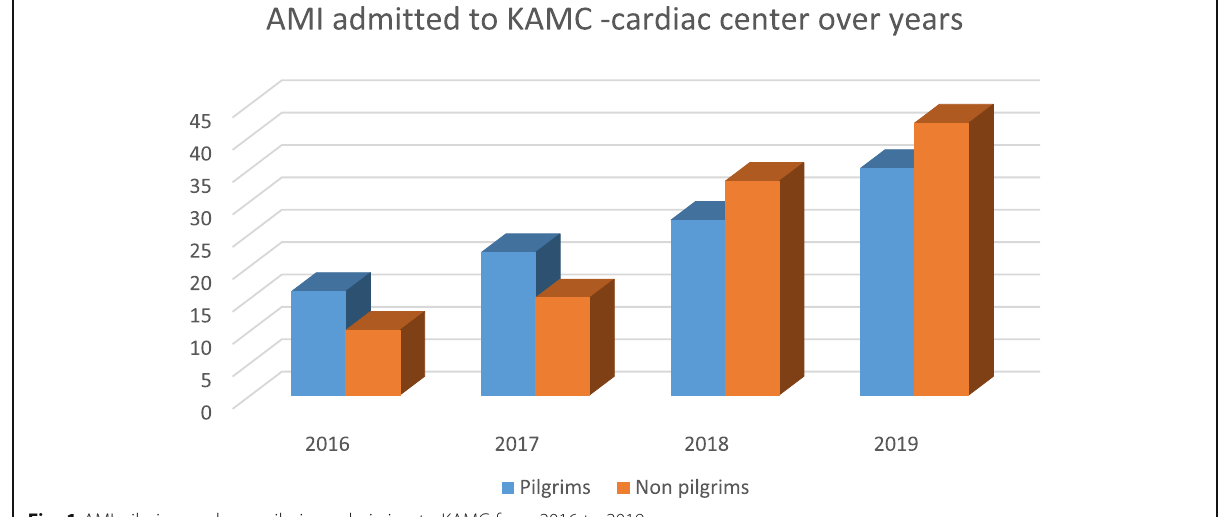
Fig. 1 AMI pilgrims and non-pilgrims admission to KAMC from 2016 to